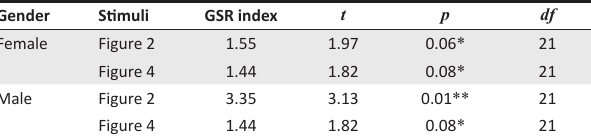
TABLE 3: Galvanic skin response results: Pictures. Gender Stimuli